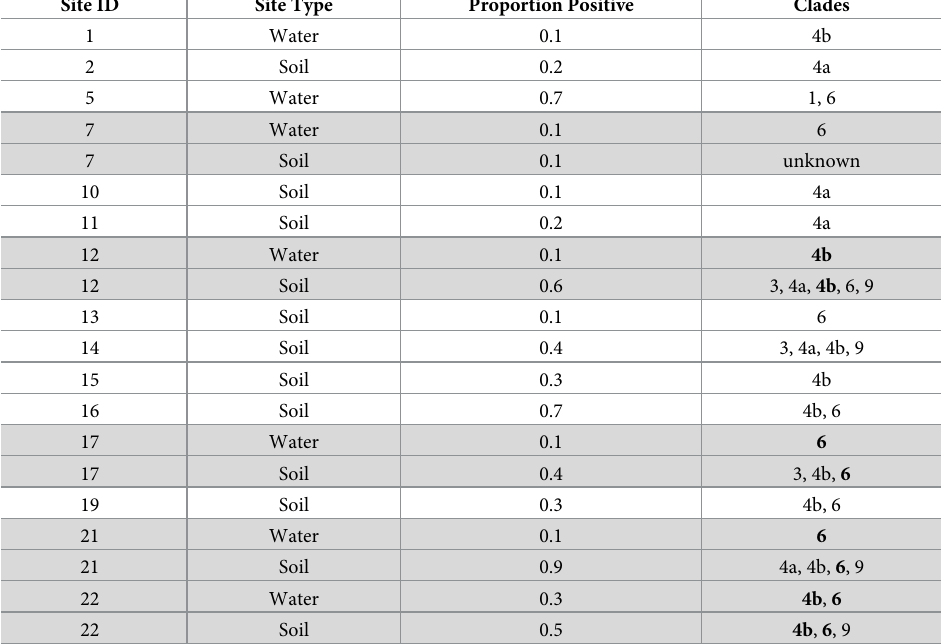
Table 1. All positive sites in Puerto Rico illustrating the relationship between lipL32 genotypes found in soil and water. In total, 15 sites were positive for pathogenic Leptospira DNA; eight sites wherein only soil was positive, two sites wherein only water was positive, and five sites wherein both soil and water were positive (highlighted in gray). At four of the latter sites, the clades present in water were a subset of the clades identified in soil (bolded text), suggesting that soil reservoirs may lead to the contamination of